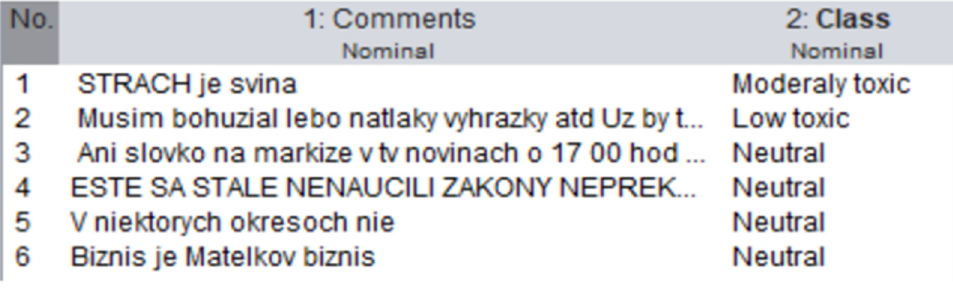
Figure 1. Illustration of the dataset of labelled comments extracted from social networks.